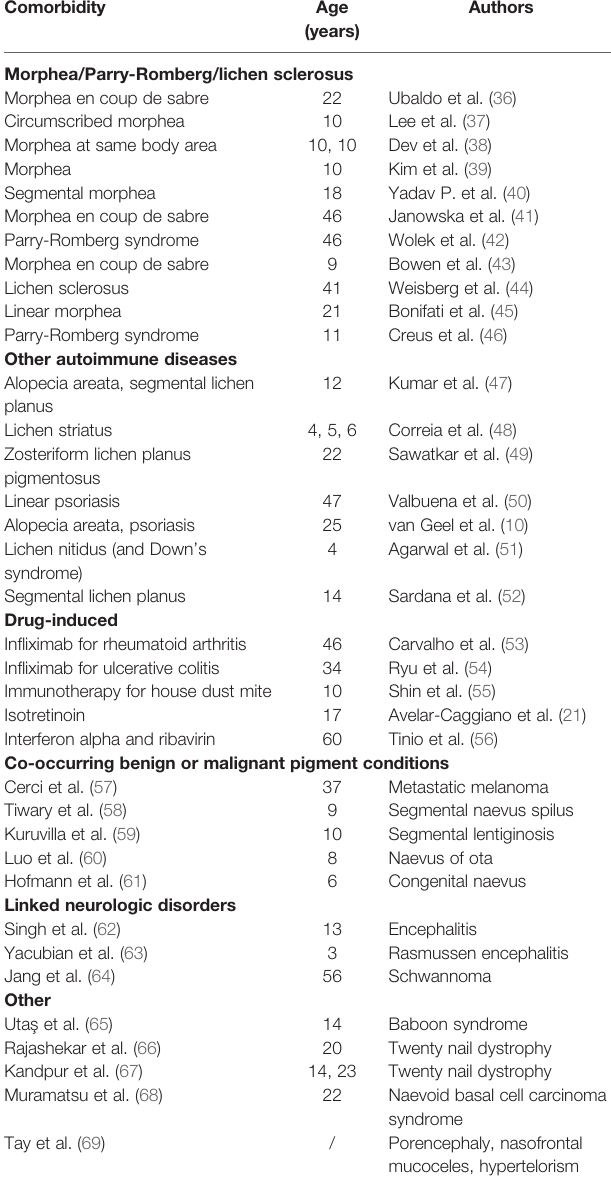
TABLE 1 | Segmental vitiligo cases with autoimmune and other